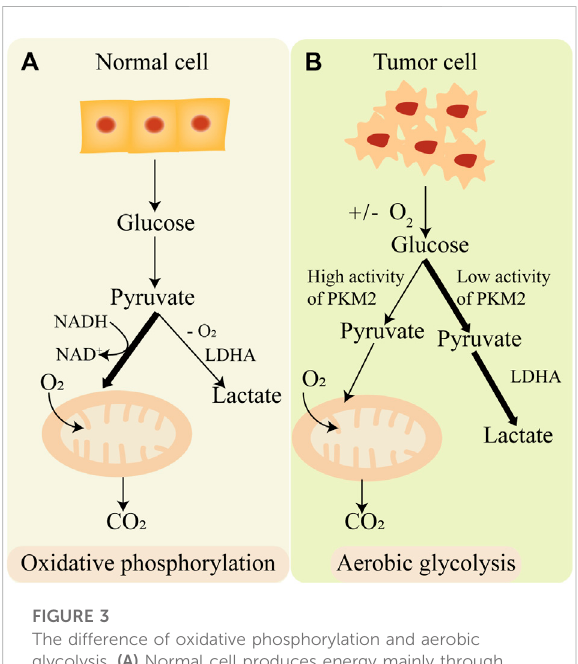
FIGURE 3 The difference of oxidative phosphorylation and aerobic glycolysis. (A) Normal cell produces energy mainly through oxidative phosphorylation. (B) Cancercellproducesenergymainly through aerobic